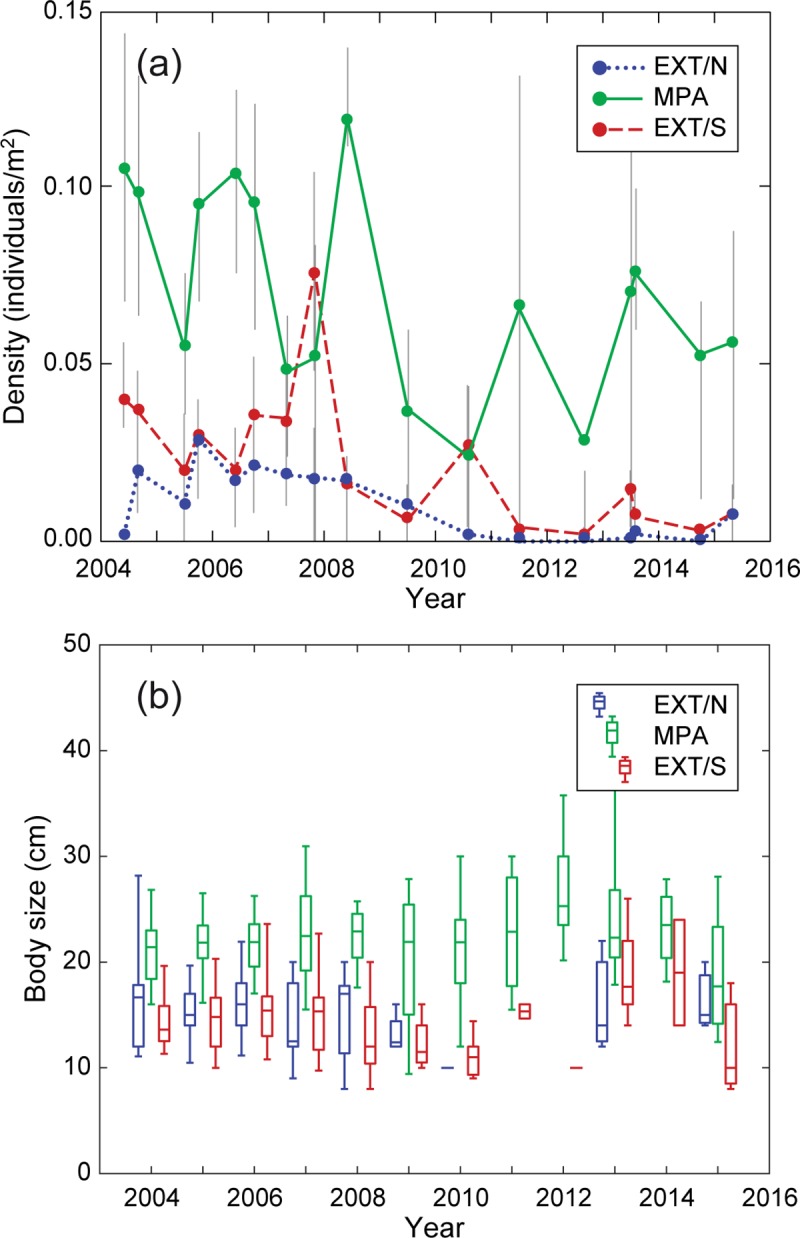
Population density and body size of Diplodus sargus sargus inside and outside Torre Guaceto marine protected area.Population density (a) and body size (b) were measured inside the protected area (MPA) and at two unprotected locations outside (EXT/N and EXT/S) via underwater visual census between 2004 and 2015. In (a), dots and vertical bars show mean and interquartile range, respectively, deriving from data variability among transects at the same location. In (b), boxes show the interquartile range (with the horizontal crossing line indicating the median) and whiskers encompass 90% CI.